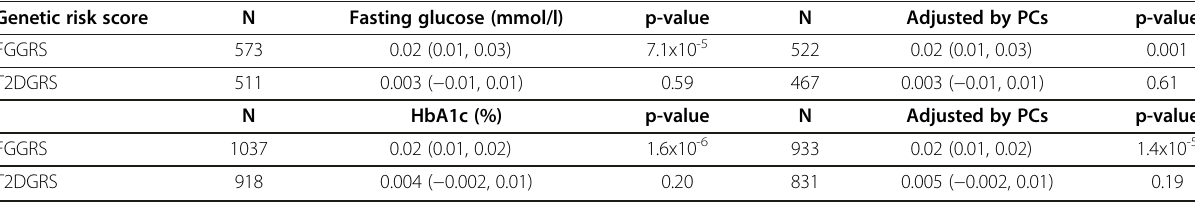
FGGRS = fasting glucose genetic risk score. T2DGRS = type 2 diabetes genetic risk score. PCs = population stratification principal